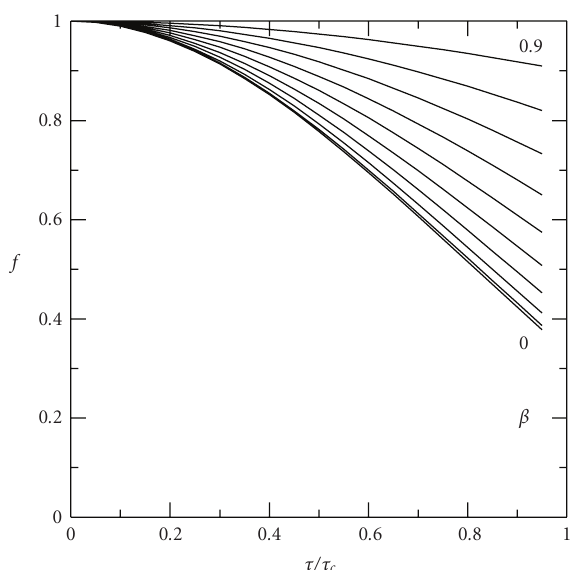
Figure 1: Eddington factor f appropriate for the RE case as a function of the optical depth τ for the various values of the flow speed β . The values of β are 0 to 0.9 in steps of from 0.1 from bottom to